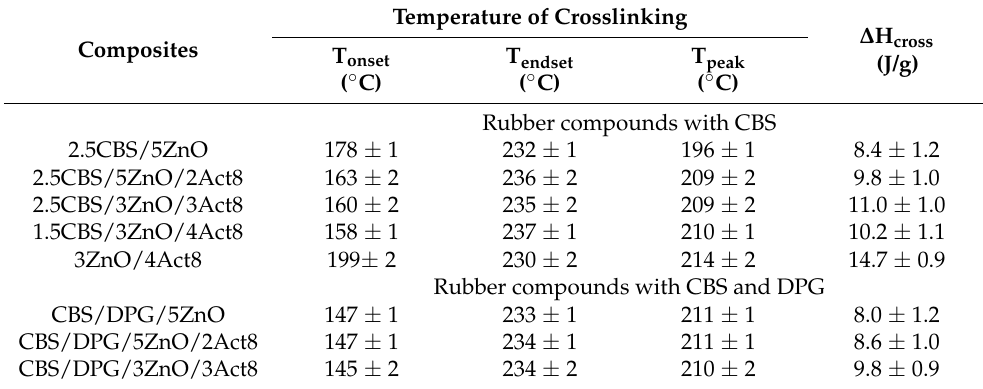
Table 3. Crosslinking temperature and enthalpy ( ∆ H cross ) of SBR compounds determined by differ- ential scanning calorimetry